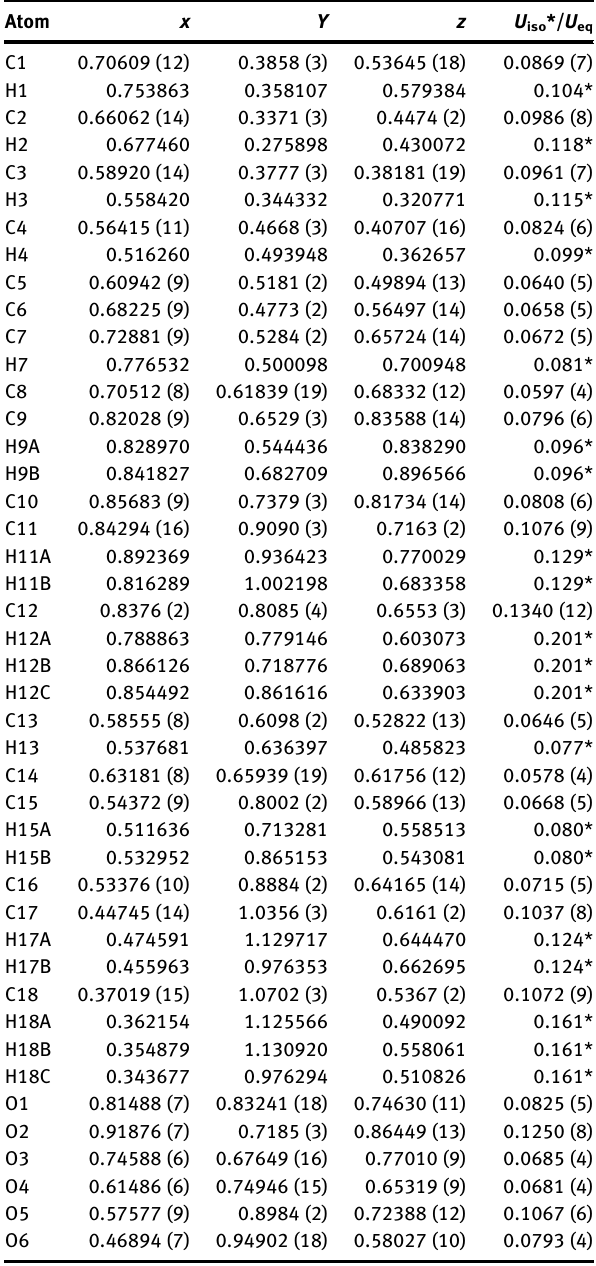
Table  : Fractional atomic coordinates and isotropic or equivalent isotropic displacement parameters (Å 